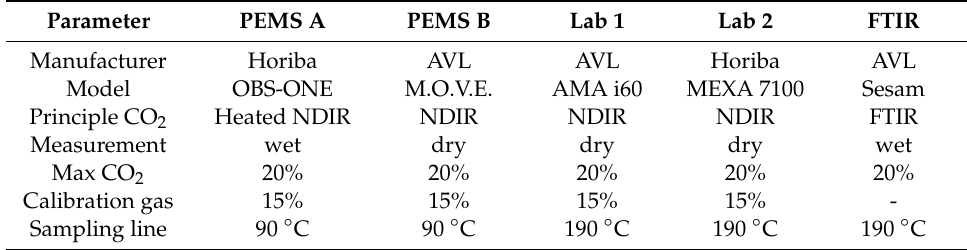
Figure 1. Experimental setup. The tests were conducted with various vehicles (Table 1) at two laboratories with different equipment (Table 2). Table 1. Characteristics of the vehicles.